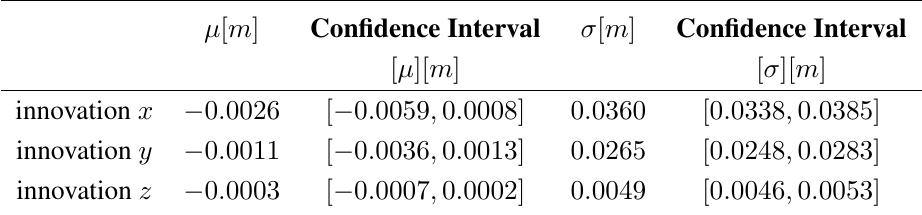
Table 3. Parameters of the normal distribution for